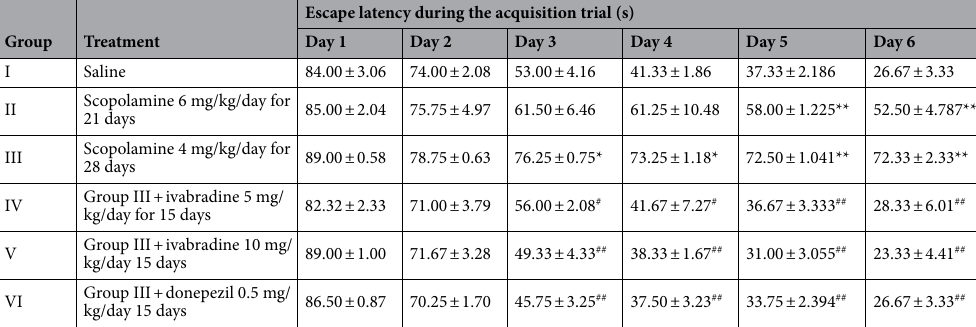
Table 1. Effect of ivabradine on escape latencies throughout the 6 successive days of the acquisition trials in Morris water maze in scopolamine induced dementia (in seconds). Values are expressed as mean ± SEM. of (8–10) rats. Analyzed using by one way ANOVA (p < 0.01). *Significant (P > 0.05) and **highly significant (P > 0.01) difference from control group. # Significant (P > 0.05) and ## highly significant (P > 0.01) difference from dementia control